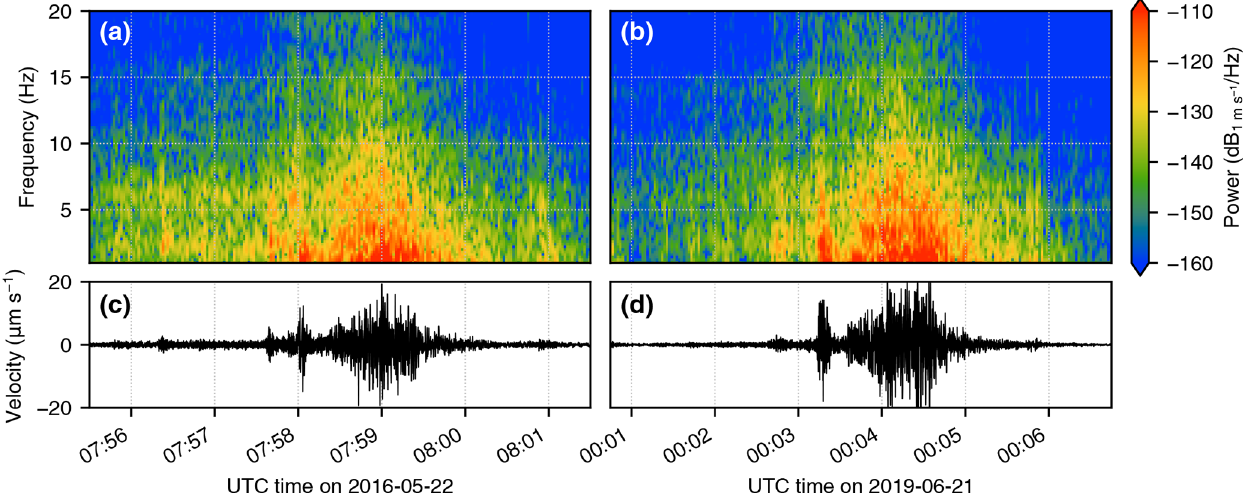
Figure 4. Vertical-component spectrograms (a, b) and seismic waveforms (c, d) from Alaska Volcano Observatory station ILSW for the 2016 (a, c) and 2019 (b, d) avalanches. Waveforms are high-pass filtered at 100s.